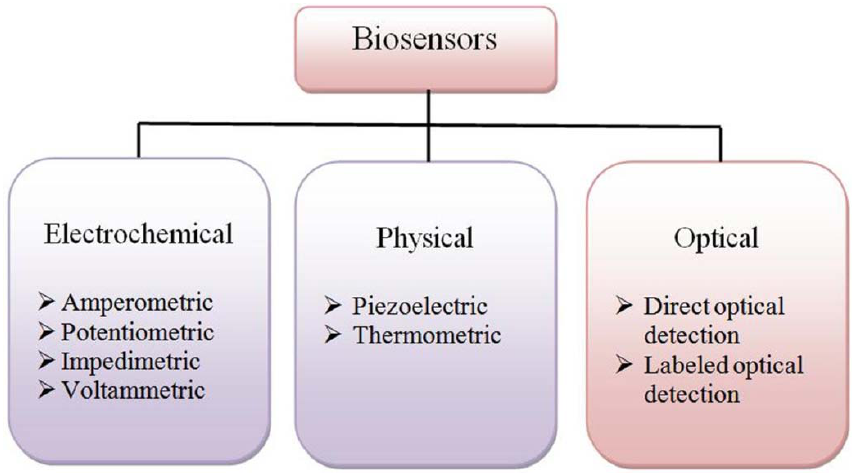
Figure 4. Types of biosensors based on their transducer operation .